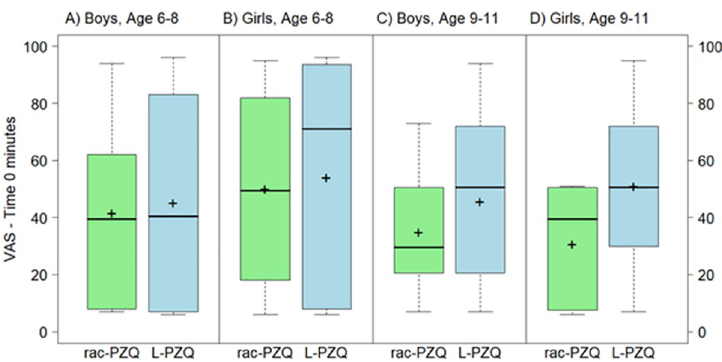
Fig 3. Boxplot of VAS scores (mm) for L-PZQ ODT and Rac-PZQ ODT without water at time 0 minutes, by gender and age. Dark lines indicate median values; ’+’ indicate mean values; the boxes represent the middle 50% of data with the bottom and top of the box represent the first and third quartiles (interquartile range, IQR); the whisker lines above and below the boxes represented the largest and smallest values that are not considered to be outliers; outliers are values that are 1.5 times the IQR below the first quartile or above the third quartile and are denoted with an open circle. https://doi.org/10.1371/journal.pntd.0007370.g003 higher by more than 15 mm (p = 0.046 and p = 0.026 at time 0 and 2–5 minutes, respectively) (Table 2). The distributions of VAS and VAS scores by gender and age group for the t = 0 t = 2–5 ODT formulations without water are shown in Figs 3 and 4. L-PZQ ODT, Rac-PZQ ODT and current PZQ-Cesol with water. The overall mean score for current PZQ-Cesol crushed in water was 20.3 (24.9) mm, while for (SD) VAS t = 0 L-PZQ ODT dispersed in water it was 67.5 (31.1) mm and for Rac-PZQ ODT dispersed in water it was 51.4 (32.4) mm. Similarly, at 2–5 minutes, the overall mean (SD) VAS scores t = 2–5 were 33.5 (22.2) for current PZQ-Cesol, 61.1 (21.2) for L-PZQ ODT and 50.2 (25.9) for Rac- PZQ ODT in water. The differences in VAS scores for L-PZQ ODT and Rac-PZQ ODT dis- persed in water compared with PZQ-Cesol were higher at both time points (p < 0.001; Table 3). Besides, there was an interaction between the L-PZQ ODT formulation and gender (interaction p = 0.004) with higher VAS scores for L-PZQ ODT in boys. When stratifying t = 0 by gender, VAS scores for L-PZQ ODT and Rac-PZQ ODT dispersed in water were also